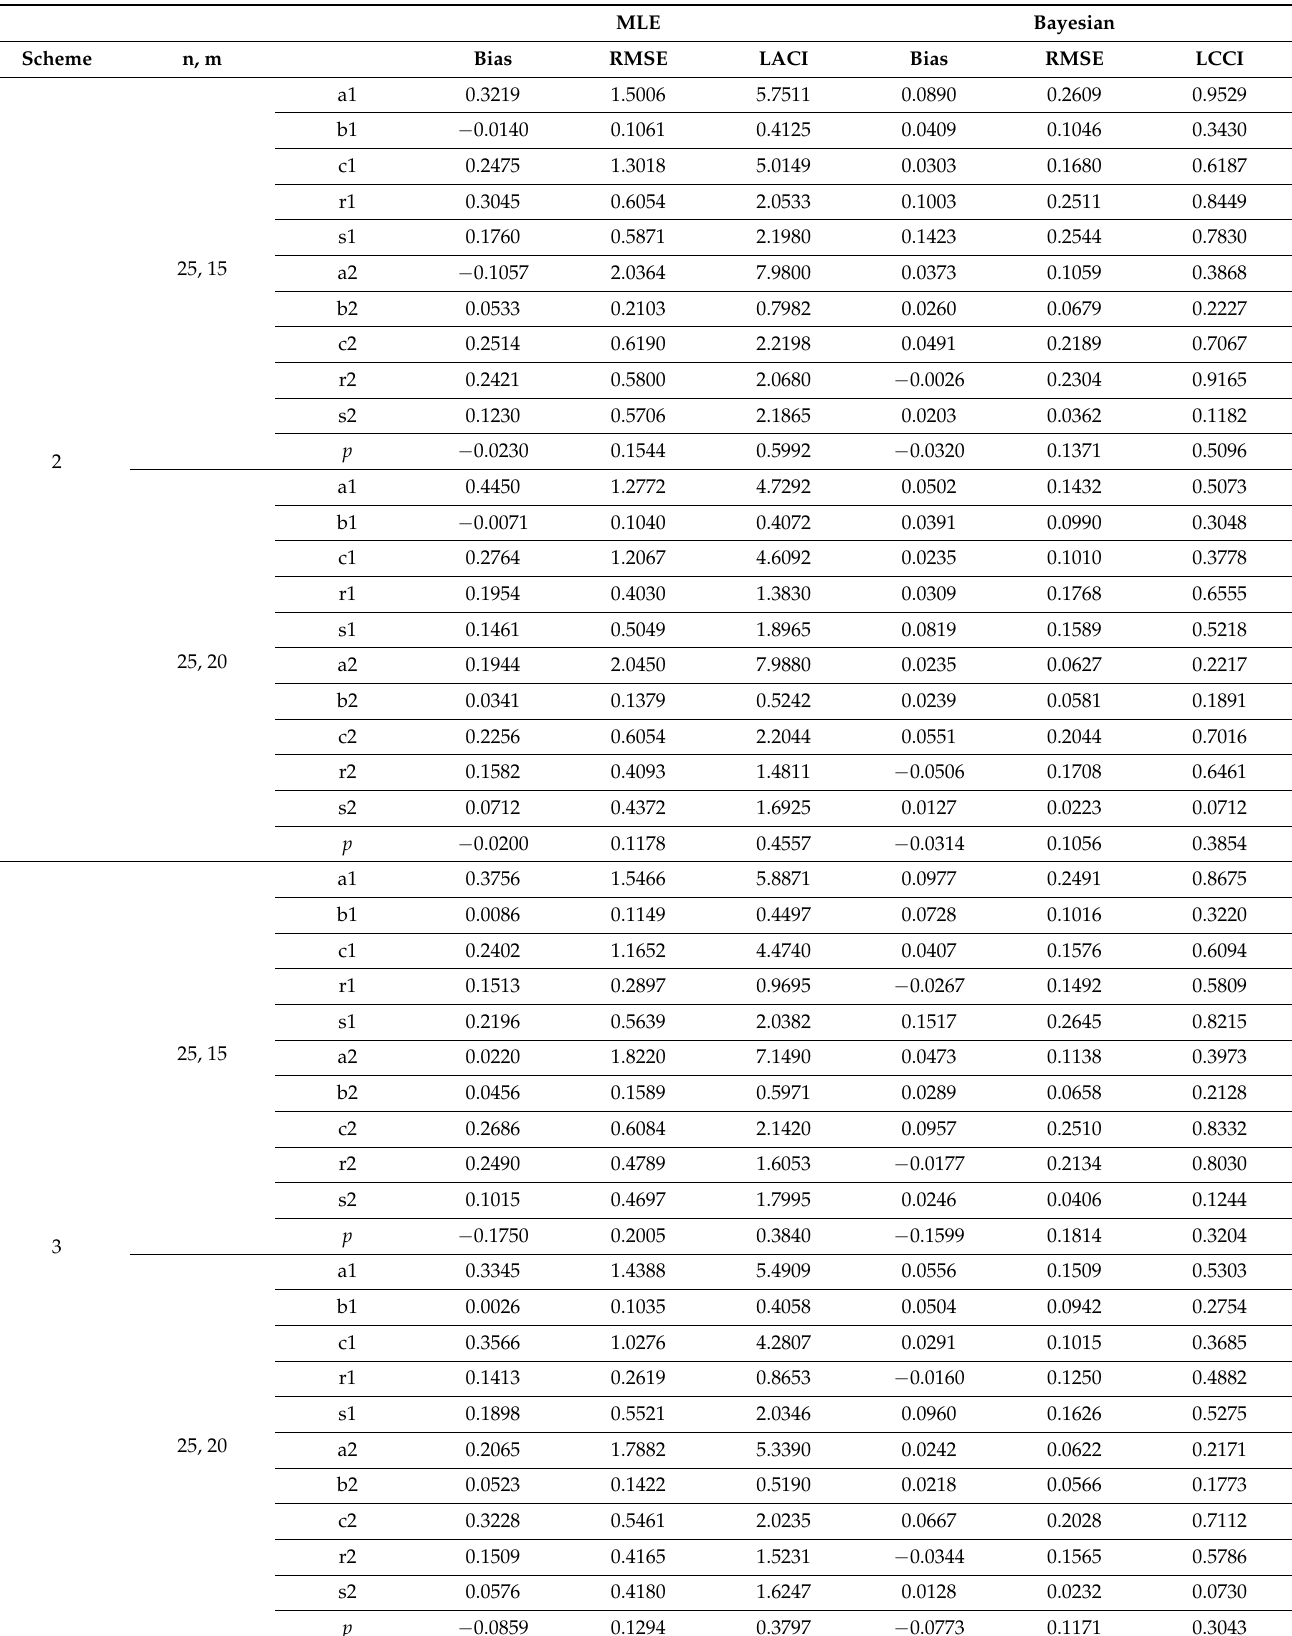
Table 6. Bias, RMSE and length of CI for the MLE and Bayesian estimates of the parameters are presented for different schemes: Case 2 and n =